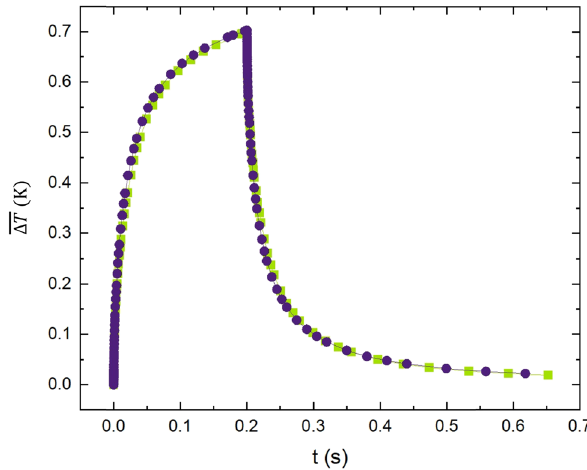
Figure 2: Finite - element simulations. Green: temporal evolution of the amplitude of the temperature increment primed on a 20 μ m skin tissue section (